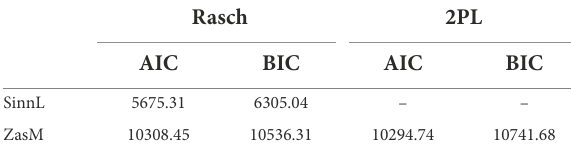
TABLE 3 AIC and BIC model fit for scaling the SinnL and ZasM items as Rasch, 2PL and 3PL